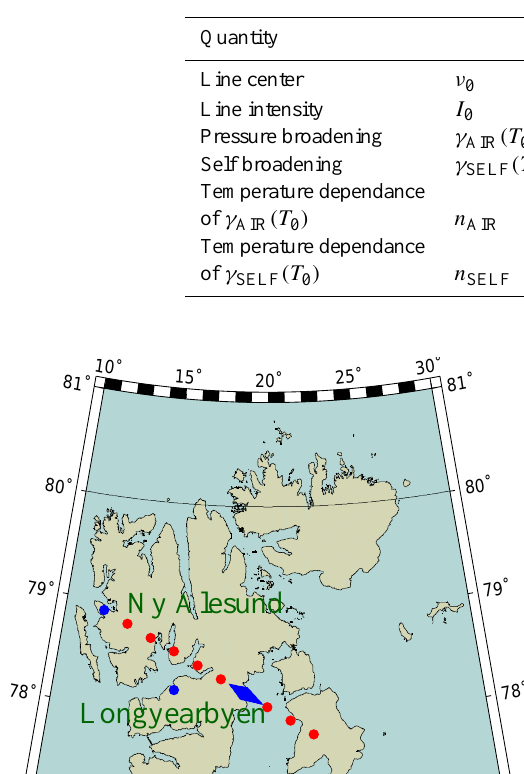
Table 2. Spectroscopic parameters for the retrieval of the data sets presented in this work.